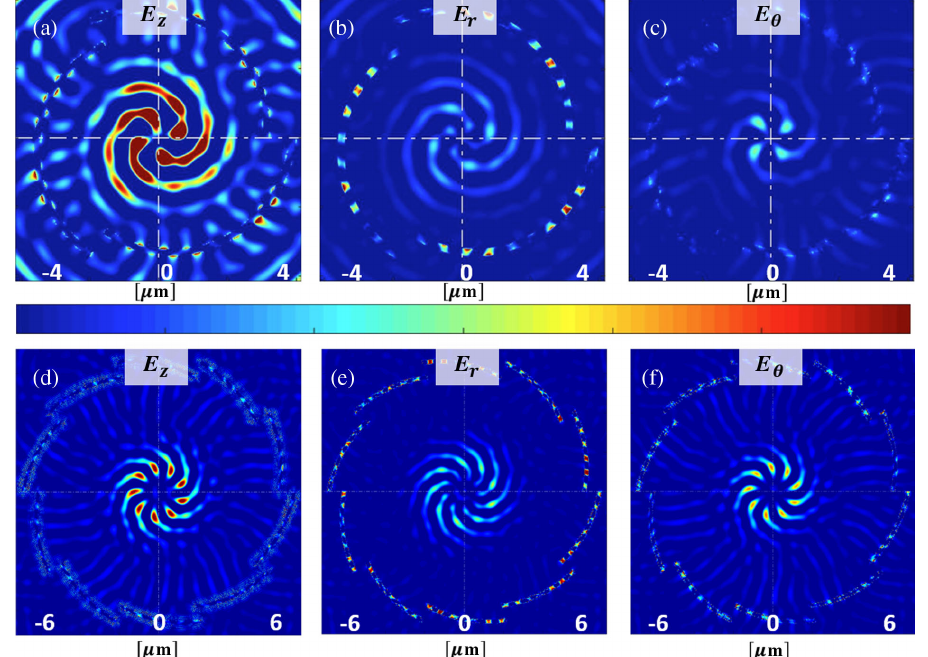
FIG. 2. Finite-difference time-domain simulation of the plasmonic vortex field. Time snapshots of the spatial distributions of vortex field components. The simulations are done within plasmonic vortex generators [7] (see SM [40]) of order m ¼ 3 and m ¼ 10 yielding l ¼ 4 [(a) — (c)] and l ¼ 9 [(d) — (f)] vortices, respectively. Each field component clearly shows 4 and 9 spiraling wave fronts and lobes. The fields are simulated outside the gold layer and are normalized between − 1 (blue) and 1 (red) of the out-of-plane